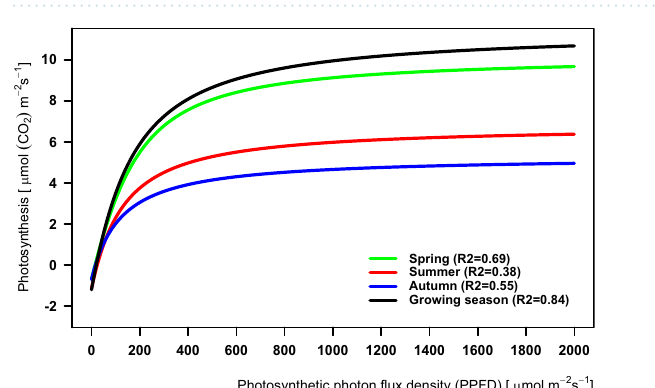
Figure 6. Parameters of the P N /I relationships: α apparent maximum quantum yield, Rd- dark respiration, I com —irradiance compensation point, A sat —light-saturated rate of photosynthesis, of the respective plant species: Ph— Phalaris arundinacea , Car— Carex acuta , Gl— Glyceria maxima , Ac— Acorus calamus , Cal— Calamagrostis canescens ). Mean (black dot) and median (thick line) are shown inside each box. Statistically significant between-species differences of each parameter are indicated by different letters above the respective boxes compared.